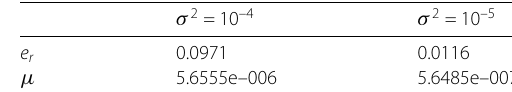
Table 1 Numerical results of the example for different σ 2 with α = 0.2